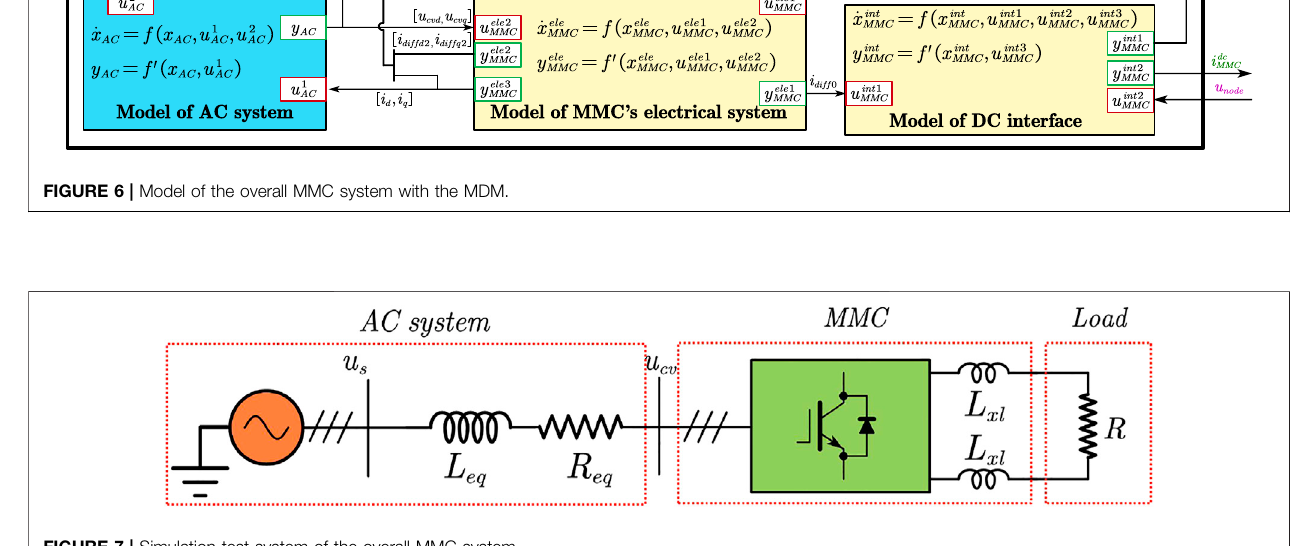
FIGURE 7 | Simulation test system of the overall MMC system.